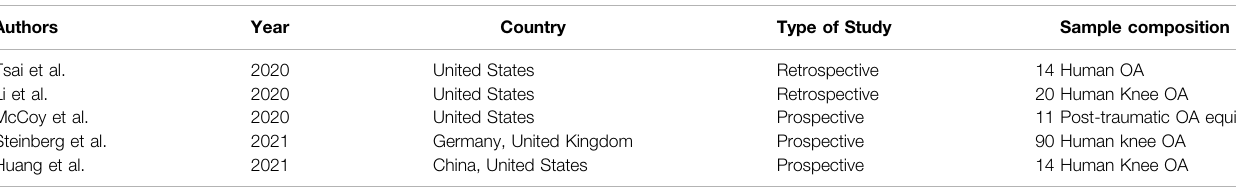
TABLE 1 | Data summary of the 5 selected articles for review.